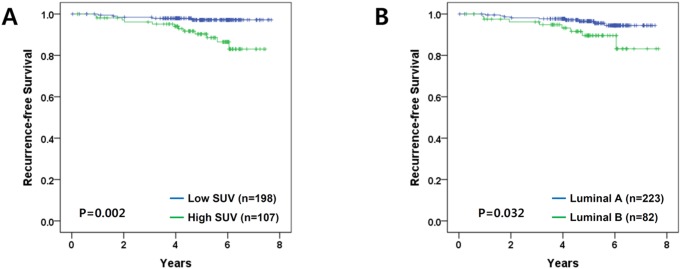
Kaplan-Meier plots for recurrence-free survival.All P-values are calculated by the log-rank test (A) Stratification by SUVmax (P = 0.002) (B) Stratification by the intrinsic subtypes (P = 0.032).